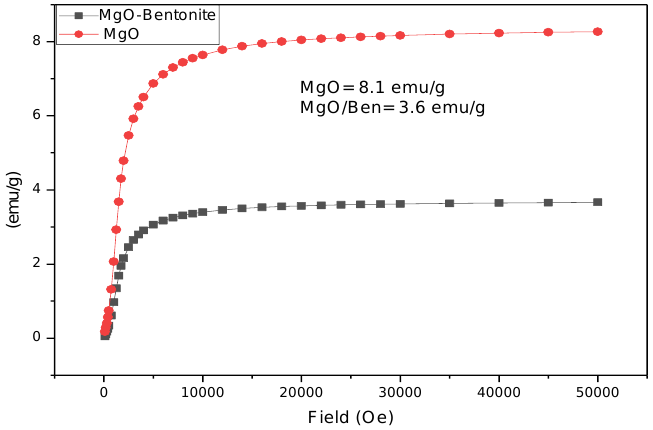
Figure 4. Magnetic properties of the prepared photocatalysts.